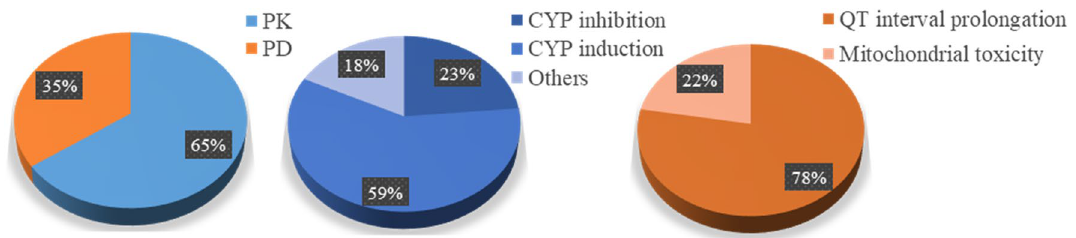
Figure 2. Mechanisms of serious potential DDIs determined by the three